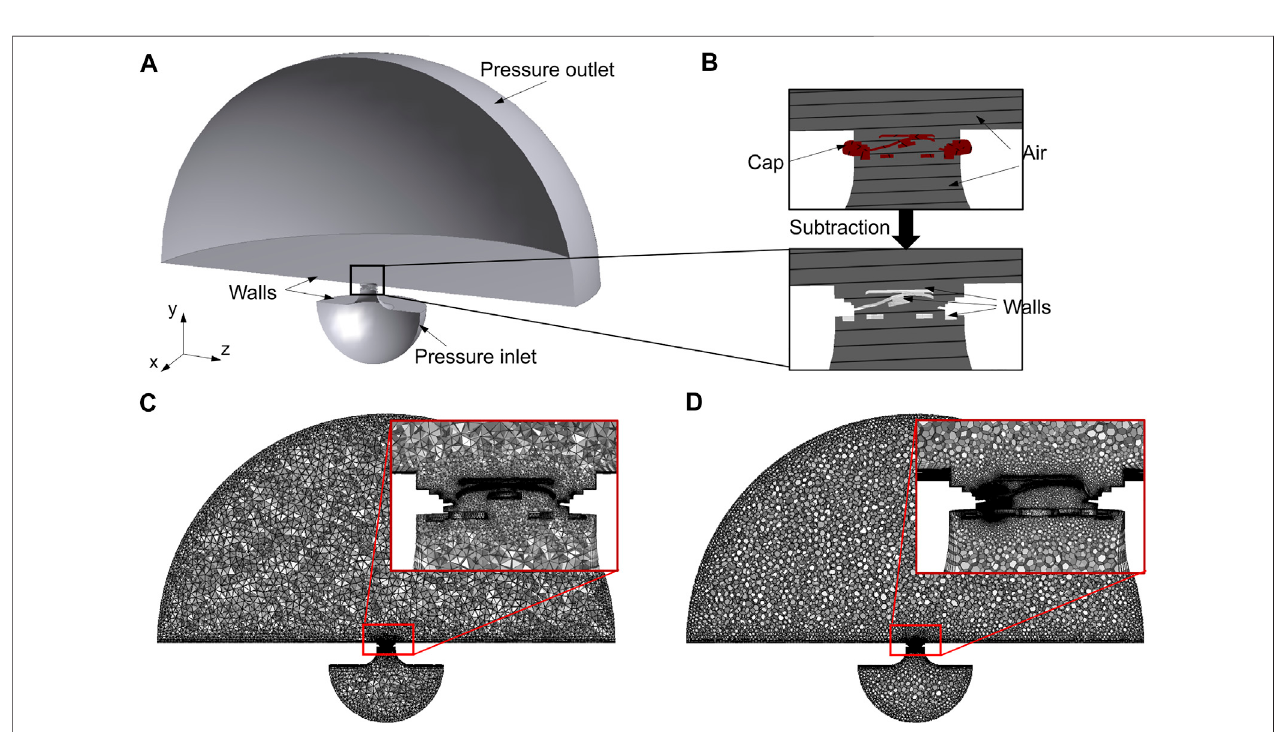
FIGURE 2 | Computational domain and boundary conditions for RANS simulations of fl ow through LIB caps (A) , schematic of the Boolean-subtraction procedure to obtain the fl uid-only computational domain (B) , fi ne tetrahedral mesh as viewed normal to the z -axis (C) , and fi ne polyhedral mesh as viewed normal to the x -axis (D)